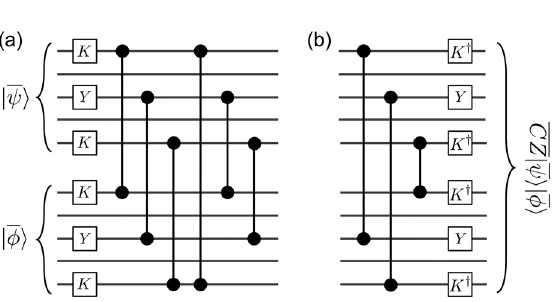
C FIG. 3. Circuits C (a) and C (b) such that C · C is a a b b a CZ ¼ pieceably fault-tolerant implementation of CZ on the 5-qubit code. The intermediate error correction, done after (a), is described in the text, while the final error correction after (b) can be taken as two copies of the canonical 5-qubit error correction, which is the canonical error correction for the tensor product of two 5-qubit codes. In the notation of the definition of ~ C C pieceable fault tolerance, · EC 1 · C . To do a logical b a CZ ¼ CX from the top code block to the bottom change all physical CZs to physical CXs from qubits in the top to those in the bottom. The intermediate error correction will still succeed in correcting all single faults if all stabilizers of the corresponding intermediate code are